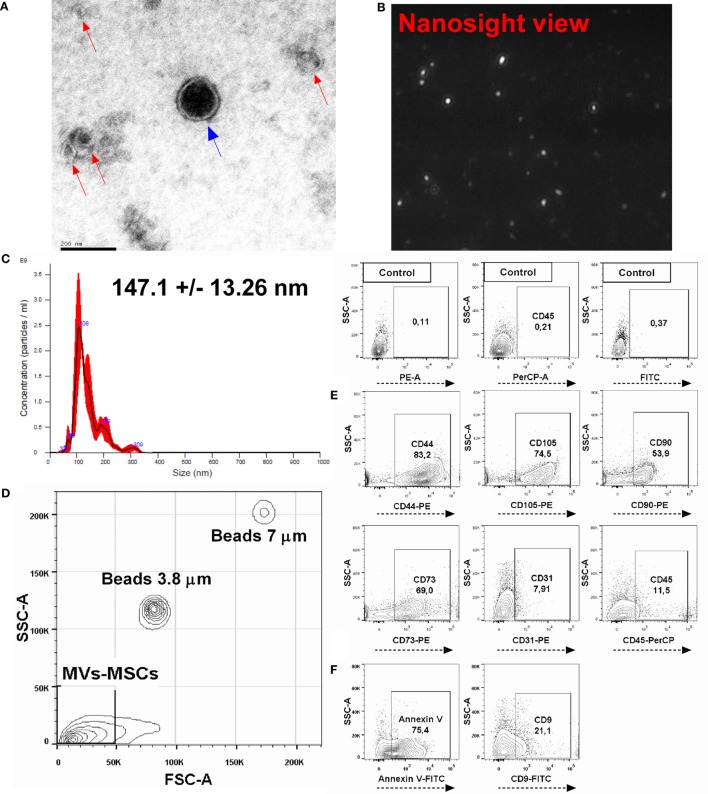
Characterization of MSCs-derived microvesicles (MVs-MSCs). (A) Electron micrographs of MVs-MSCs showing a circular and double-membrane structure; in the center of the field an MV (blue arrow) is observed, and other vesicles distributed around it compatible with exosomes (red arrows). (B) MVs-MSCs viewed by nanosight; (C) analysis of size and concentration of MVs-MSCs with nanoparticle tracking analysis; (D) FACS parameter analysis (SSC, complexity and FSC, size) of MVs-MSCs populations using defined beads; (E) investigation of MSCs immunophenotype panel in MVs-MSCs suspension, and (F) expression of annexin V and CD9 in MVs-MSCs surfaces. In general, MSCs-derived particles presented features of the parental cells with classical MVs profile (*P < 0.05, **P < 0.01, ***P < 0.001).